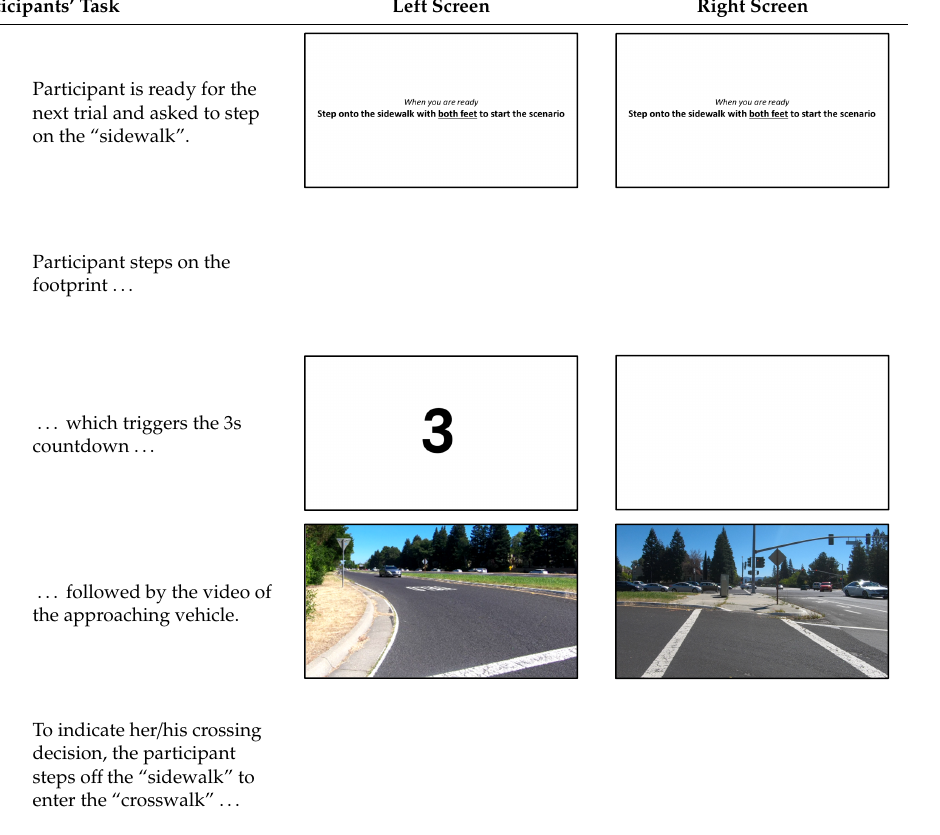
Table 1. Participants’ task and video flow.